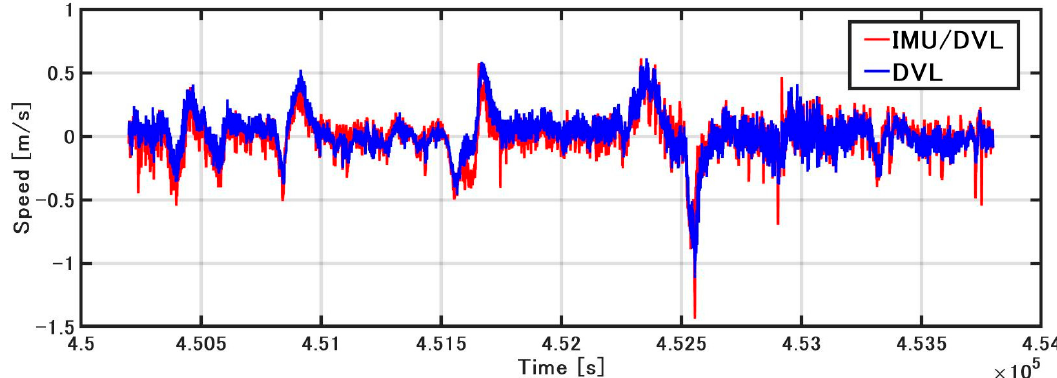
Figure 10. Speed error comparison.